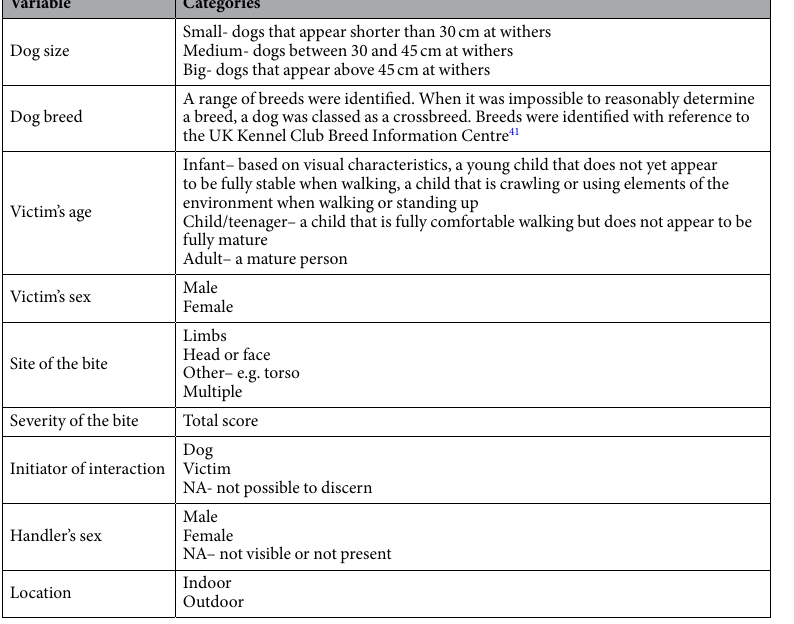
Table 1. Variables describing dog, victim, context and bite characteristics.